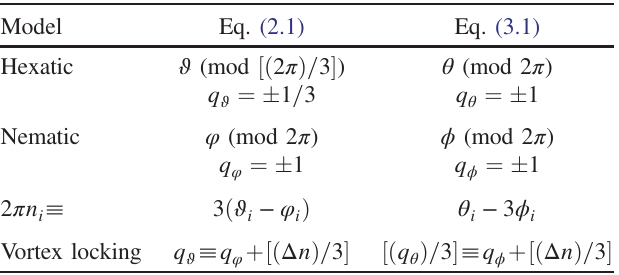
TABLE I. Lexicon between the different notations of Eqs. (2.1) and (3.1), establishing the link between the two conventions. The elementary vortex charges are added in the first two lines. The expressions of the last line are understood modulo